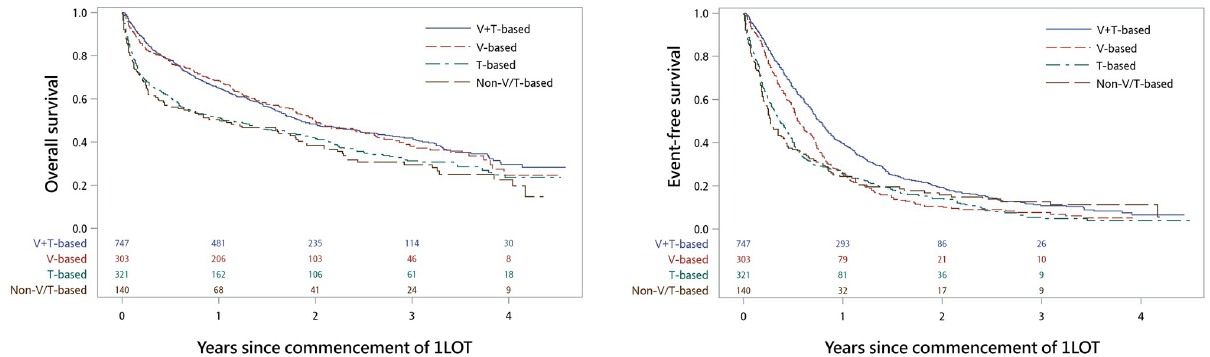
Fig 2. Overall survival (A) and event-free survival (B) of the 1LOT groups. In the analysis of event-free survival, the number of surviving patients at four years were less than three in some of the treatment groups; therefore, the data are not shown to protect the anonymity of the